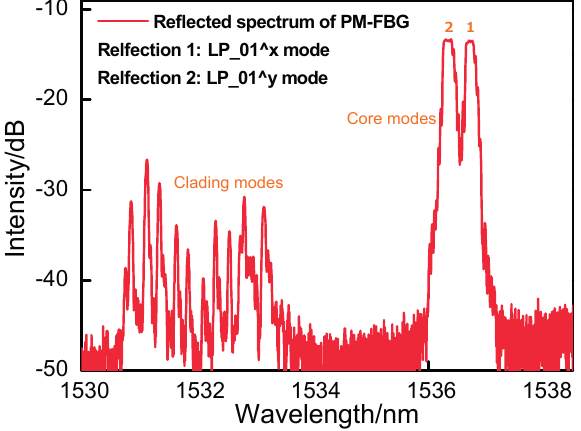
Figure 2. Experimentally measured reflection spectrum of sensing